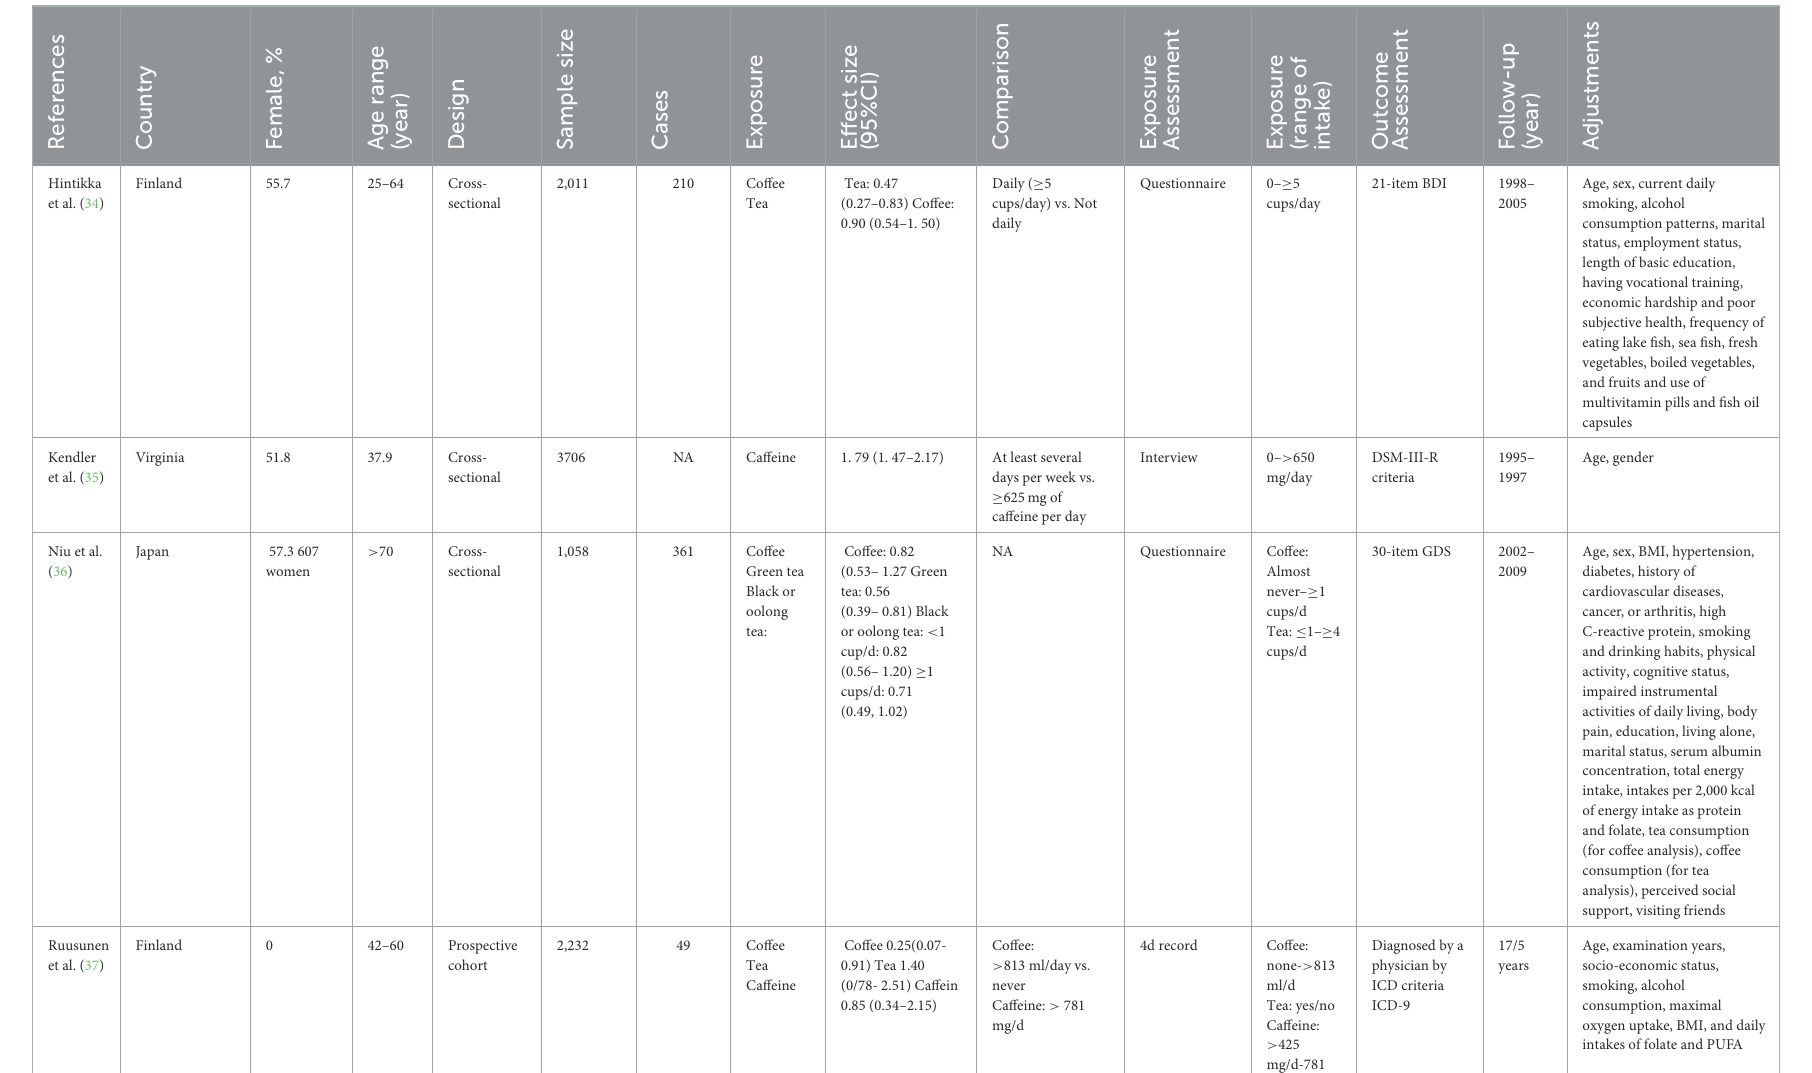
TABLE 1 Characteristics of included